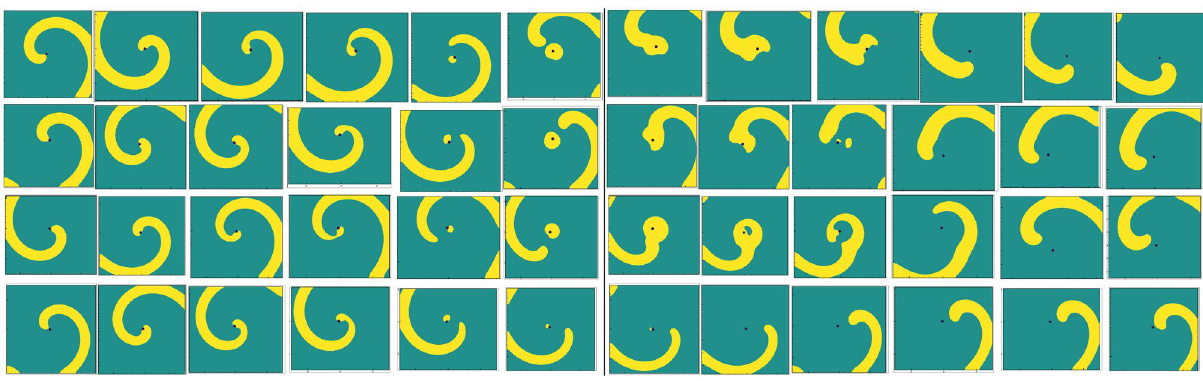
Figure 5. Earliest evolution of the spiral waves for in the presence of the circular obstacle (blue spot) for 101.1 ≤ t ≤ 103.0 for a = 1.45 (top row), a = 1.50 (second row), a = 1.60 (third row) and a = 1.72 (bottom row) showing the spiral wave front hitting the obstacle, breaking up and then merging once